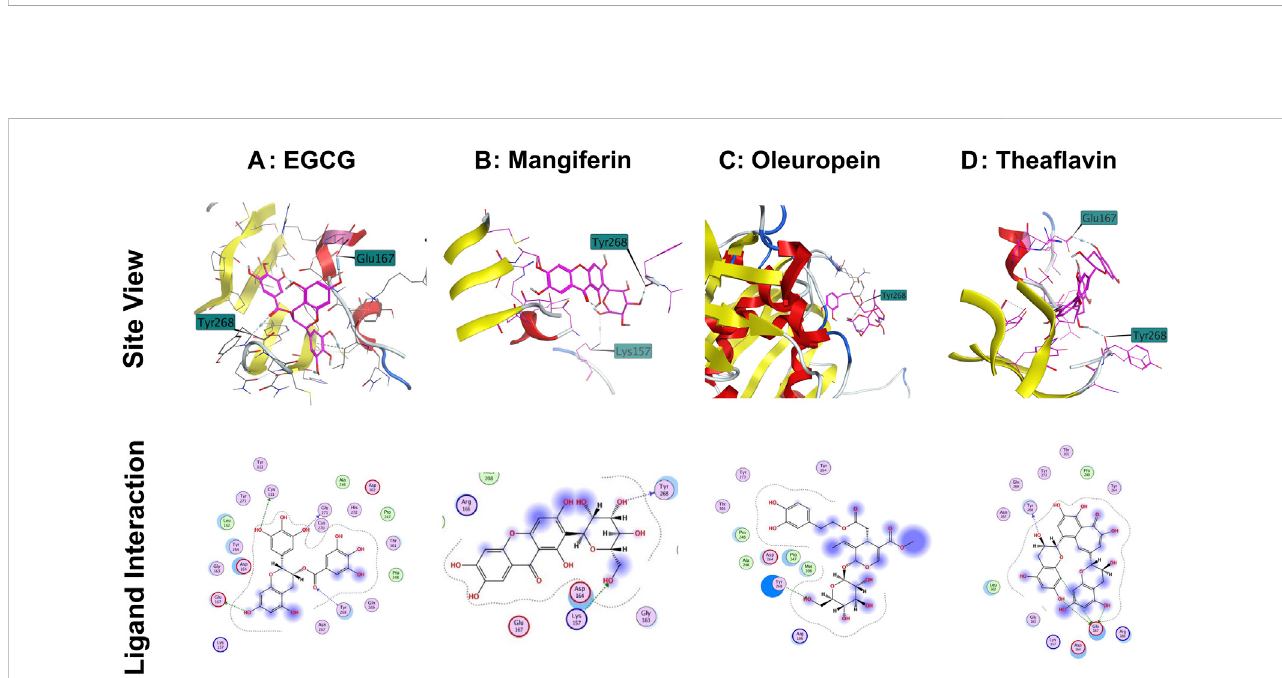
Interaction of selected phytochemicals with SARS-CoV-2 PLpro. (A) Interaction of EGCG with Glu 167 , Cys 111 and Tyr 268 of PLpro through hydrogen bonding. (B) Interaction of mangiferin with Tyr 268 and Lys 157 of PLpro through hydrogen bonding. (C) Interaction of oleuropein with Tyr 286 of PLpro through hydrogen bonding. (D) Interaction of Thea fl avin with Try 268 and Glu 167 of PLpro through hydrogen bonding. Site view and ligand interaction maps were presented to illustrate the hydrogen bonding.